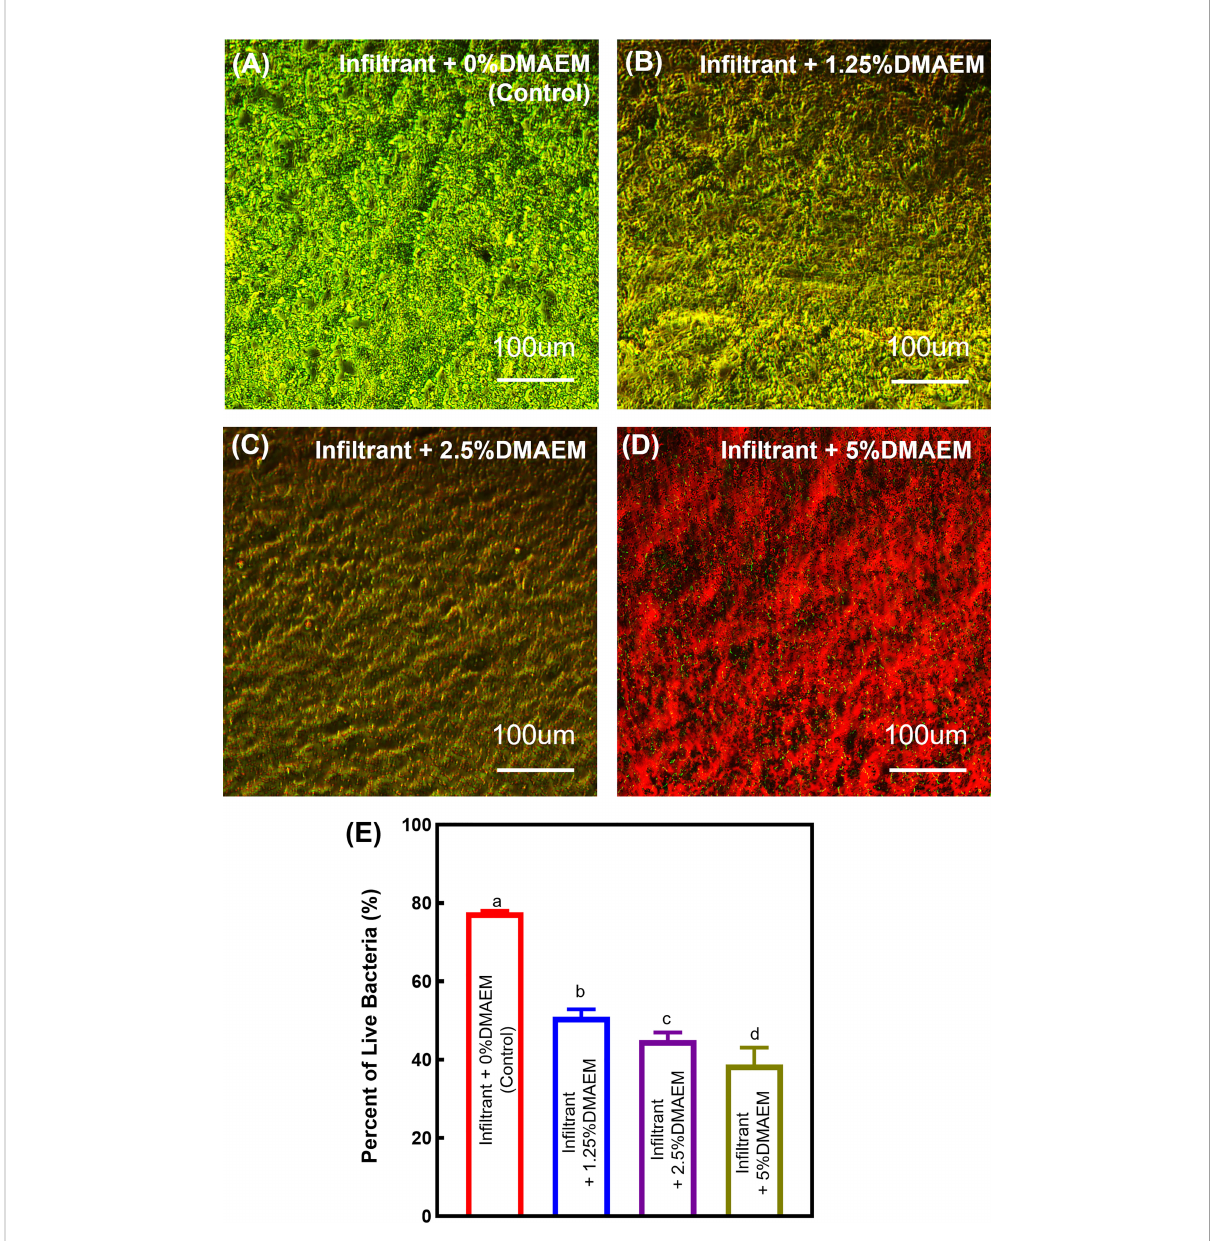
FIGURE 6 Representative images of live/dead stained bio fi lms grown for 24 h on composites. (A) In fi ltrant + 0% DMAEM group, (B) in fi ltrant + 1.25% DMAEM group, (C) in fi ltrant + 2.5% DMAEM group, (D) in fi ltrant + 5% DMAEM group, (E) percent of live bacteria(%). Live bacteria were stained green and dead bacteria were stained red. In fi ltrant + 0% DMAEM group had primarily live bacteria, while in fi ltrant + 5% DMAEM group produced mostly red